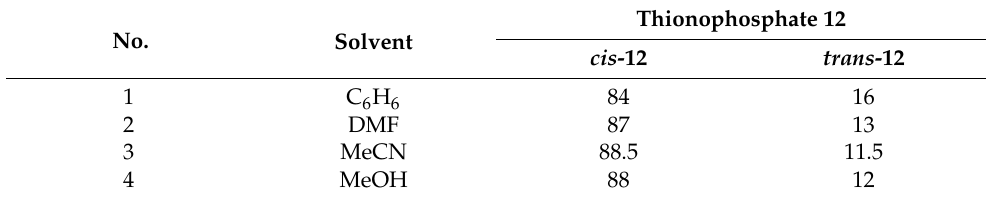
Table 4. Effects of solvents on percentage of cis - and trans -thiophosphates 12 obtained in methanolysis of thiophosphoryl fluoride cis - 6 ( F ).